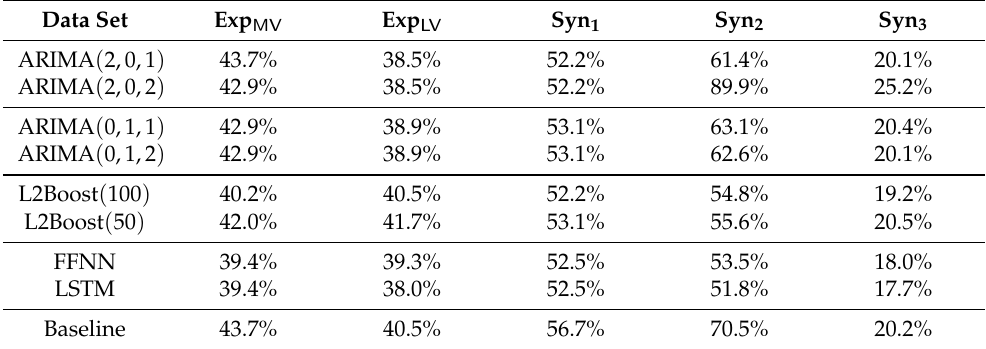
Table 1. Normalized RMSE performance of time-series prediction for the average SNR of the first stabilizer batch.